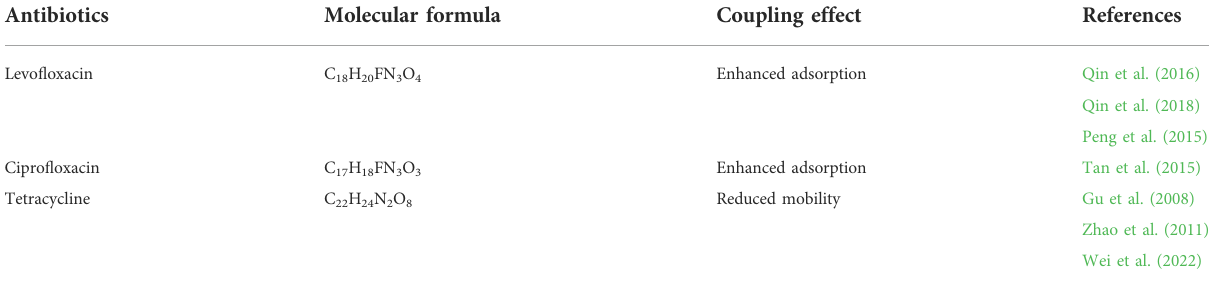
TABLE 3 Coupling effect of goethite and organic matter on migration of